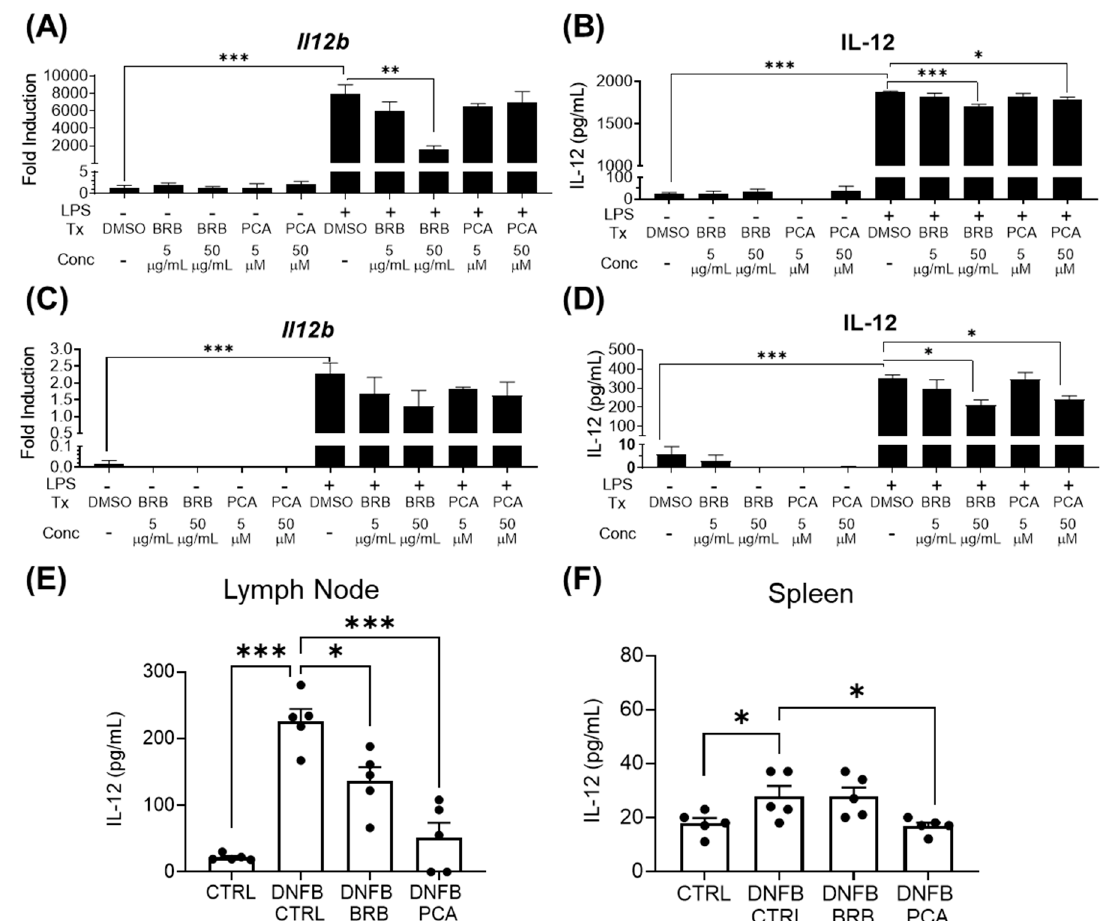
Figure 3. IL-12, a key mediator of DNFB-induced CHS, is reduced by black raspberry extract (BRB-E) and PCA. ( A ) Fold induction of Il12b expression in activated bone marrow-derived dendritic cells at 24 h after LPS stimulation. ( B ) IL-12 production by activation study bone marrow-derived dendritic cells, 24 h after LPS stimulation. ( C ) Fold induction of Il12b expression by RAW264.7 macrophages after 12 h after LPS stimulation. ( D ) IL-12 production by RAW264.7 macrophages after 24 h of LPS stimulation. ( E , F ) IL-12 production (pg/mL) by cells taken from the ( E ) draining lymph nodes after 24 h of CD3 stimulation and ( F ) spleen after 12 h of CD3 stimulation. * p -value < 0.05; ** p -value < 0.01; *** p -value < 0.005 for comparisons between DNFB-challenged mice fed control diet and comparison groups using Student’s t test, and for comparisons between DMSO control samples and comparison groups.